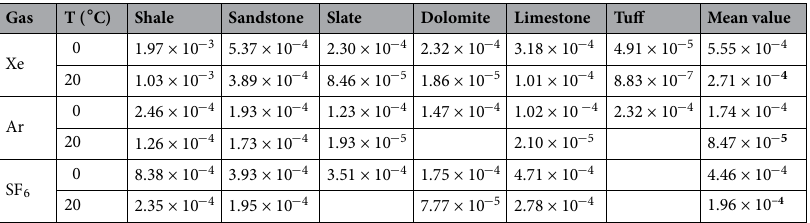
3 1 kg − ) of xenon, argon, and SF 6 in various geologic